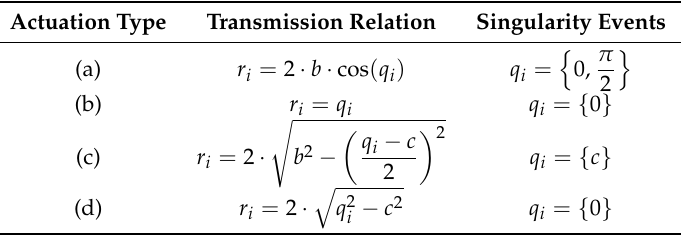
Table 1. For each actuation strategy, geometrical relation between q i and r i , and singularity conditions for q i